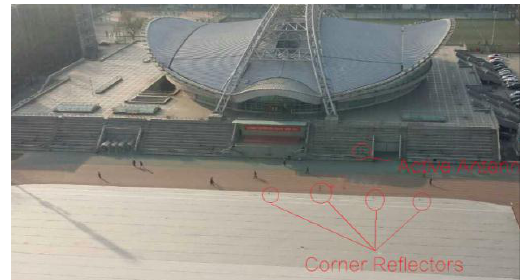
Figure 19. Imaging scene of this experiment.